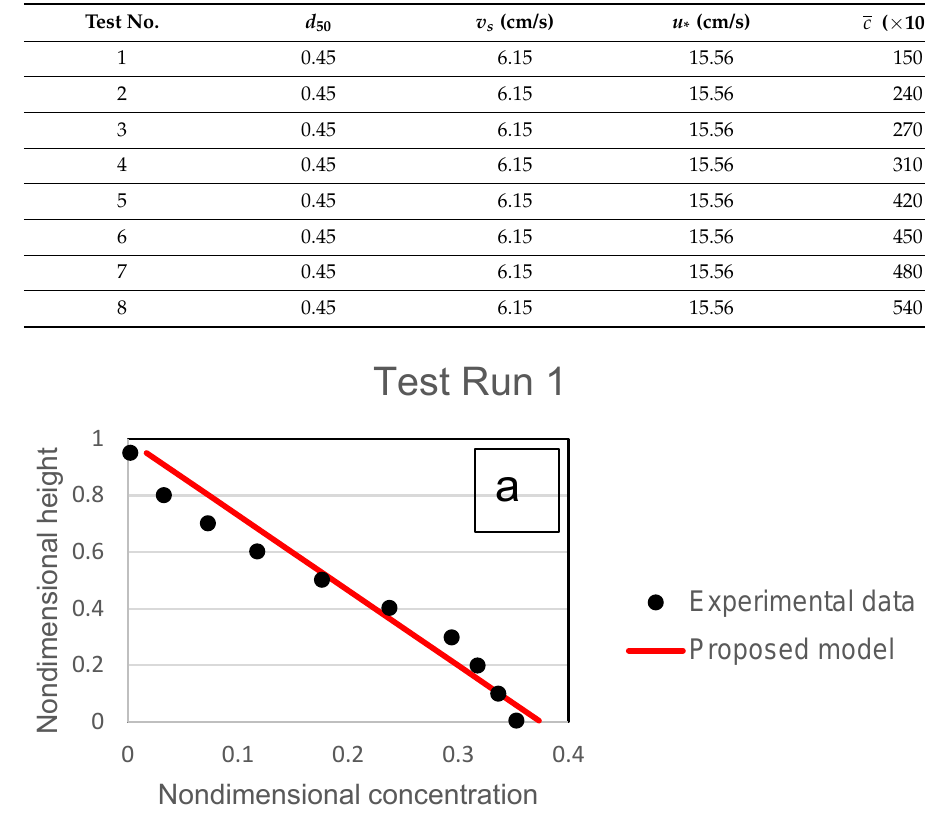
Table 5. Data by Michalik [36].